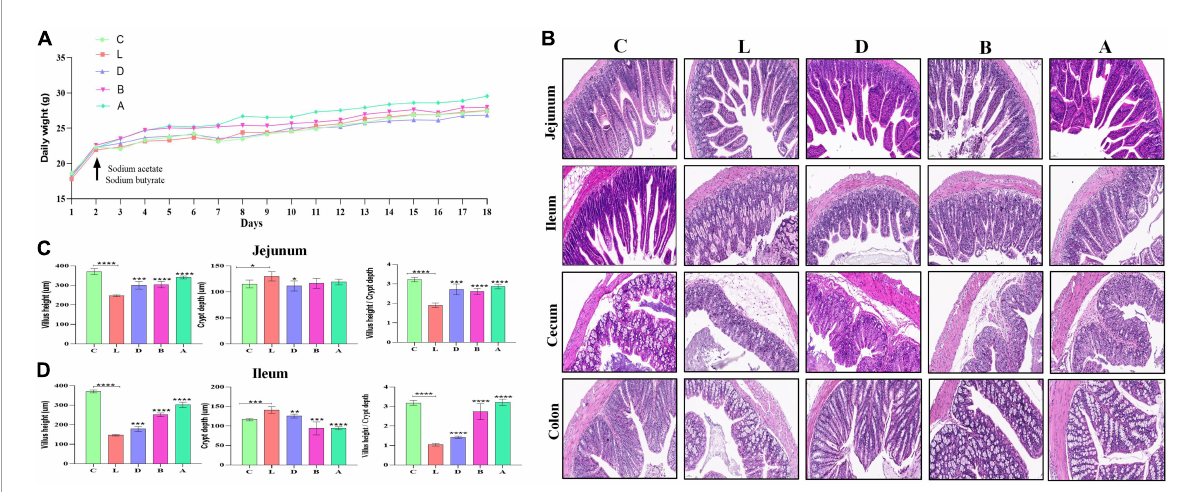
FIGURE2 Effects of sodium acetate/sodium butyrate supplementation on body weight, diarrhea score, and intestinal damage induced by LPS. (A) Mouse daily weights, (B) H&E staining analysis of small intestine of mouse, (C) villus height, crypt depth, and villus height/crypt depth ratio of Jejunum, and (D) villus height, crypt depth, and villus height/crypt depth ratio of Ileum. Scale bar 50 µ m. Significance is presented as * p < 0.05, ** p < 0.01, *** p < 0.001, and **** p < 0.0001; data are presented as the mean ± SEM ( n = 3).